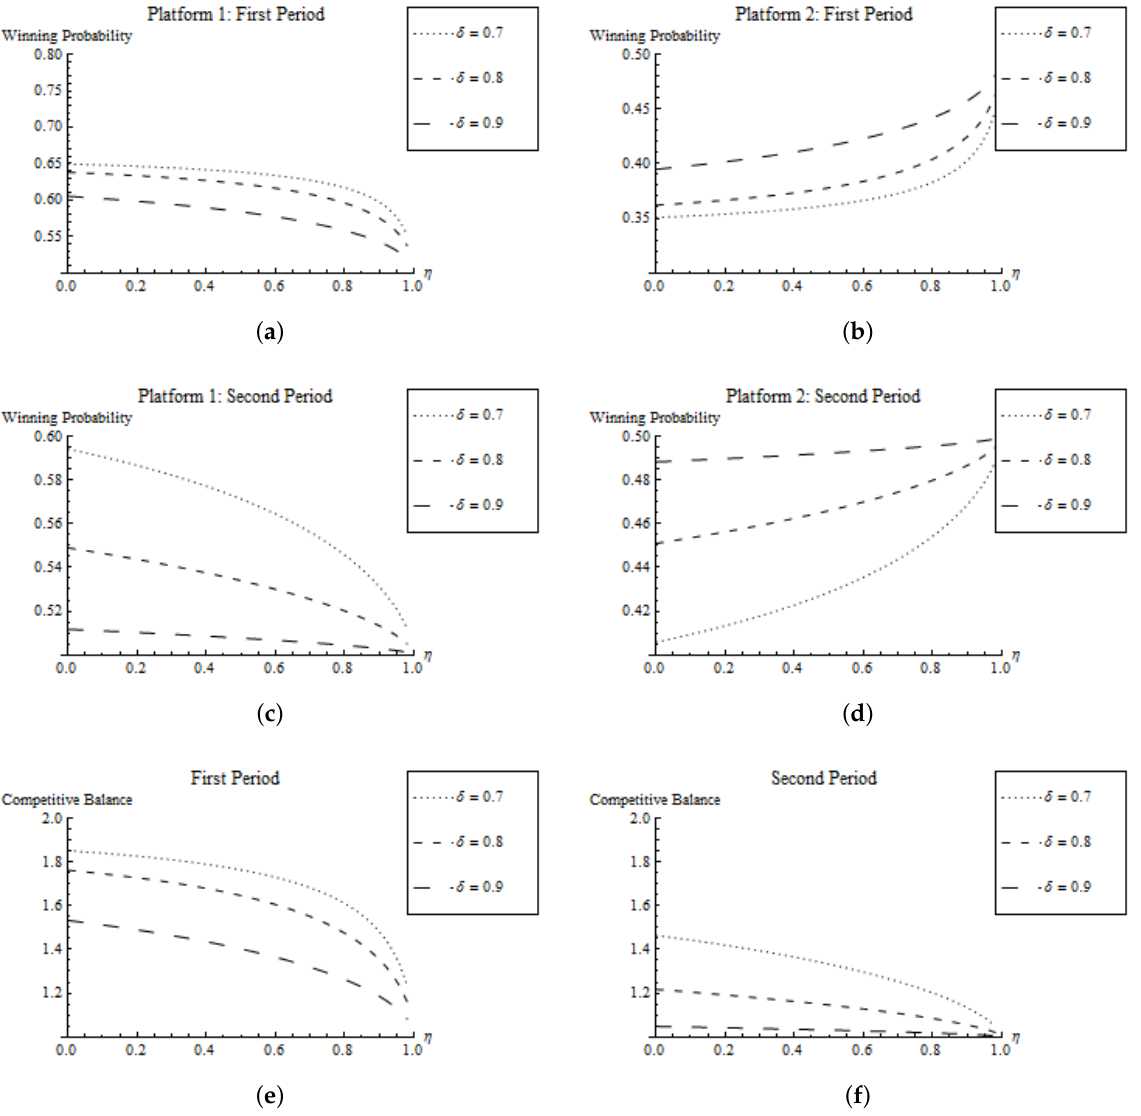
Figure 3. Winning probabilities and competitive balance for quadratic costs. ( a ) Platform 1: First period, ( b ) Platform 2: First period, ( c ) Platform 1: Second period, ( d ) Platform 2: Second period, ( e ) First period, ( f ) Second